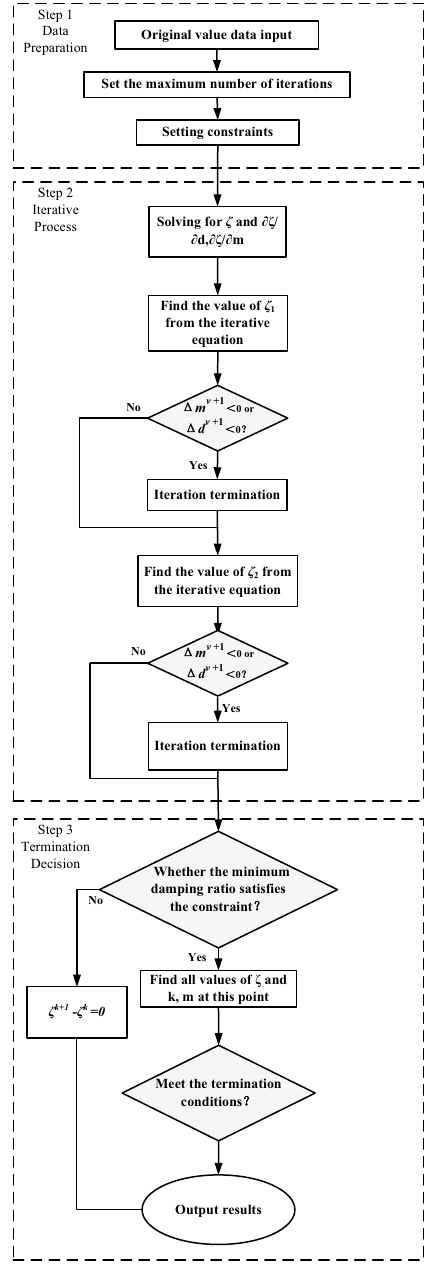
Figure 5. Diagram of two areas power